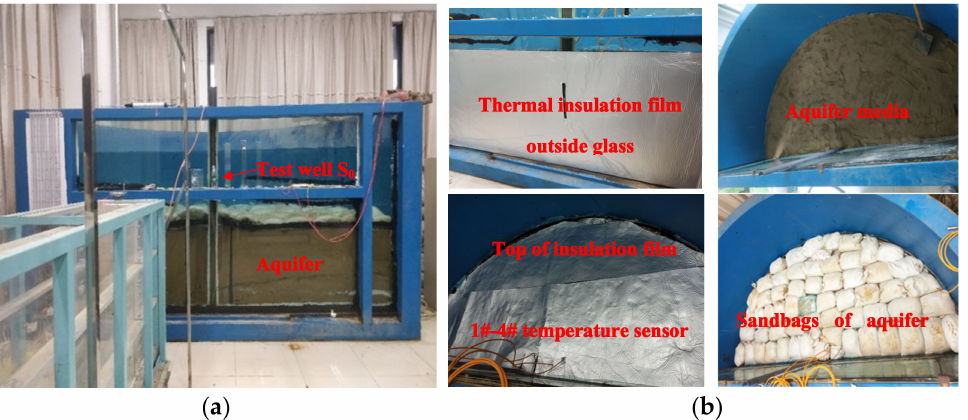
Figure 5. Physical picture of the test platform. ( a ) Appearance of the test platform frame; ( b ) Internal construction of aquifer system.